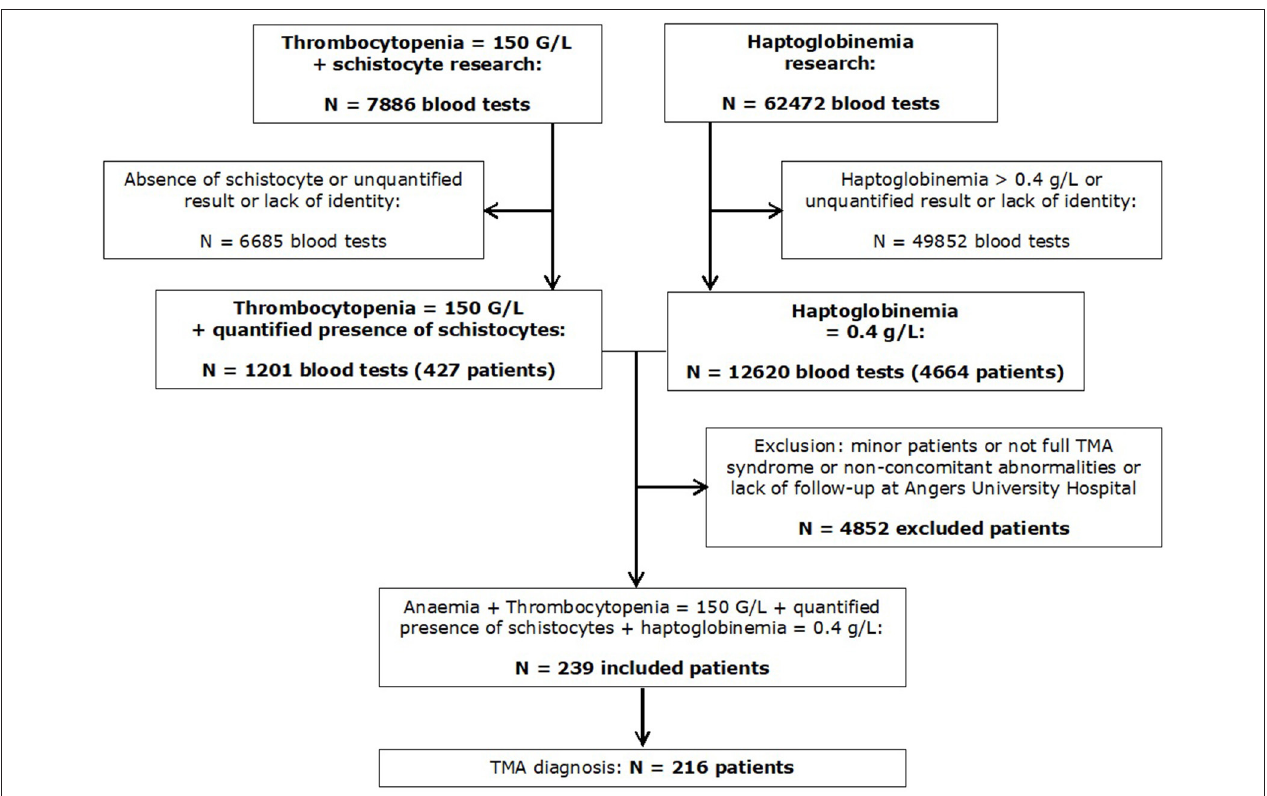
FIGURE 1 | Flowchart of the